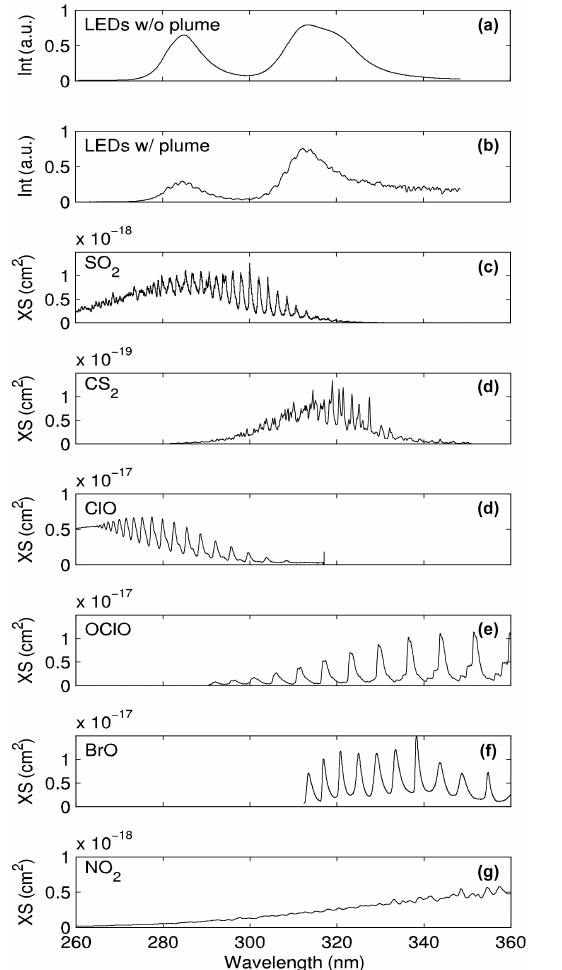
Figure 2. (a) Relative intensity of the three UV LEDs recorded when no plume was in the instrument’s path. (b) Light intensity recorded when a plume drifted into the open path of the instrument. (c–f) Absorption cross sections (Wahner et al., 1988; Bogumil et al., 2003; Vandaele et al., 2009) of various trace gases that can be mea- sured with the portable LP-DOAS system. Note that the LED emis- sion spectrum overlaps the cross sections of SO 2 , CS 2 and ClO. The LEDs selected for these measurements were chosen specifically to provide sensitivity to these